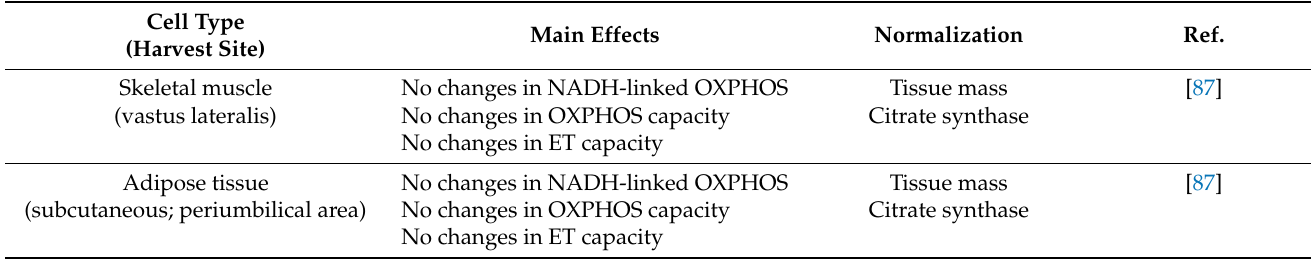
Table 5. High-resolution respirometry findings in